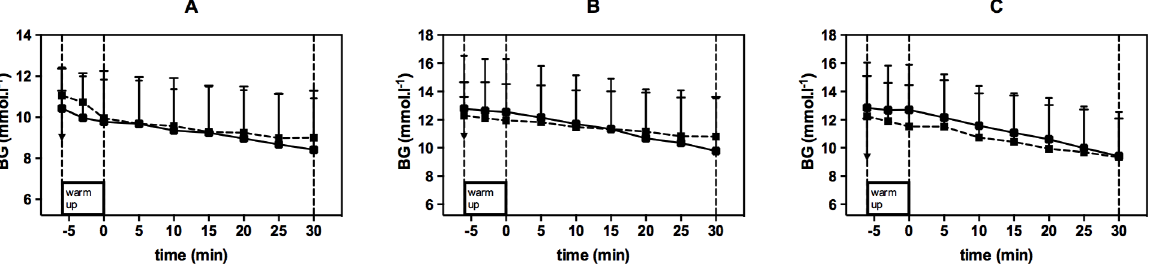
Fig 6. Comparison of blood glucose (BG) decrease during high-intensity interval exercise (dotted line) vs. continuous exercise (full line) for exercise intensities A, B, and C. Values are given as mean and SD.